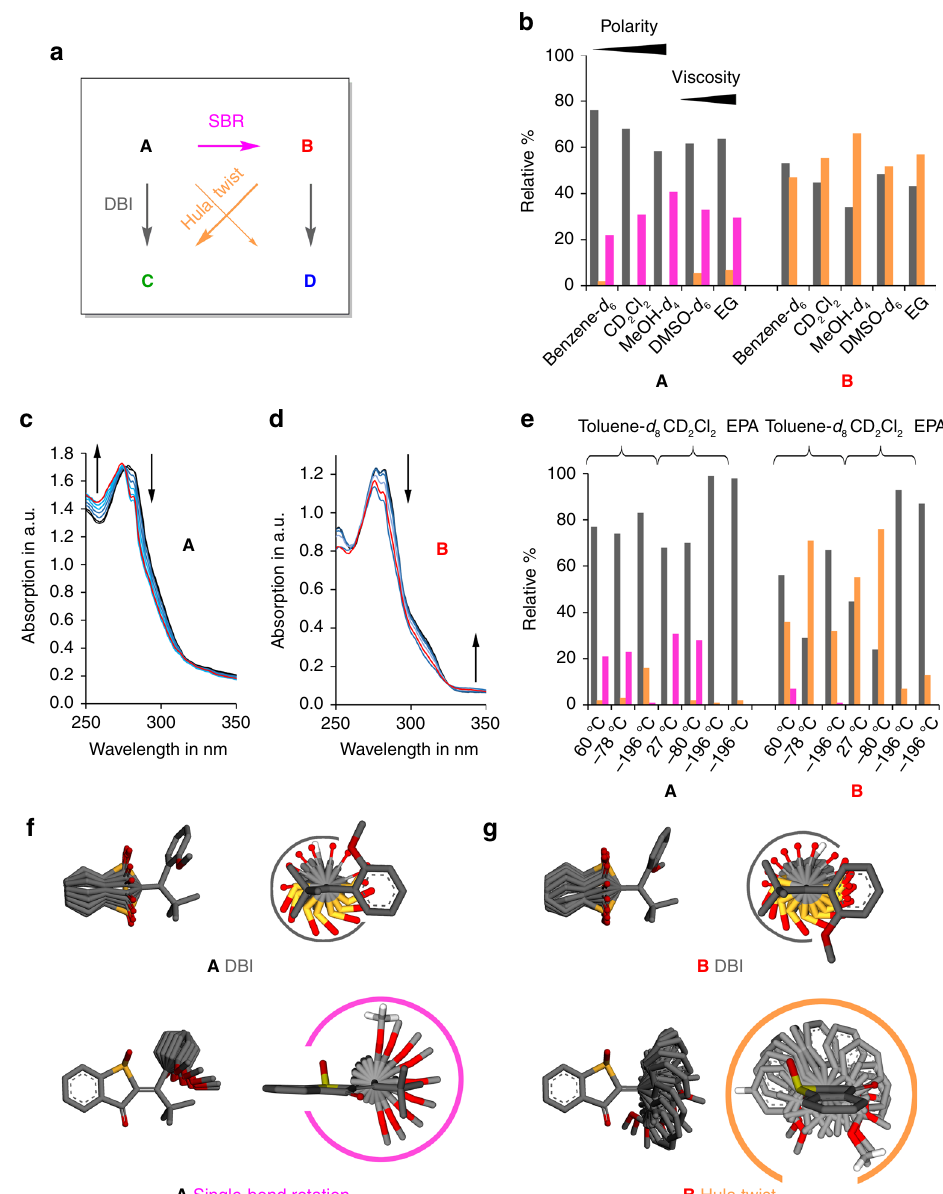
Fig. 4 Photoreactions of A and B under different conditions. a The different photo processes are color coded: SBR in purple, DBI in gray, and HT in orange. b Dependence of the photoinduced motions on solvent polarity and viscosity. The relative ef fi ciencies of different processes are derived from a Markov- matrix analysis of the corresponding 1 H NMR data. c Ultraviolet/vis absorption changes (arrows) observed during irradiation of A at − 183 °C within an EPA matrix. No signi fi cant spectral changes are observed after warming the sample to − 80 °C and recooling to − 183 °C (red spectrum). d Ultraviolet/vis absorption changes observed during irradiation of B at − 183 °C within an EPA matrix. No signi fi cant spectral changes are observed after warming the sample to − 80 °C and recooling to − 183 °C (red spectrum). e Dependence of the photoinduced motions on temperature and rigidity of the medium. The relative ef fi ciencies of different processes are derived from a Markov-matrix analysis of the corresponding 1 H NMR data. f Approximated volume changes of A during DBI (top) and SBR (bottom). Two different views are shown. The required volumes for individual motions are emphasized by color coded circles, perspectives are at the same scale. g Approximated volume changes of B during DBI (top) and HT motion